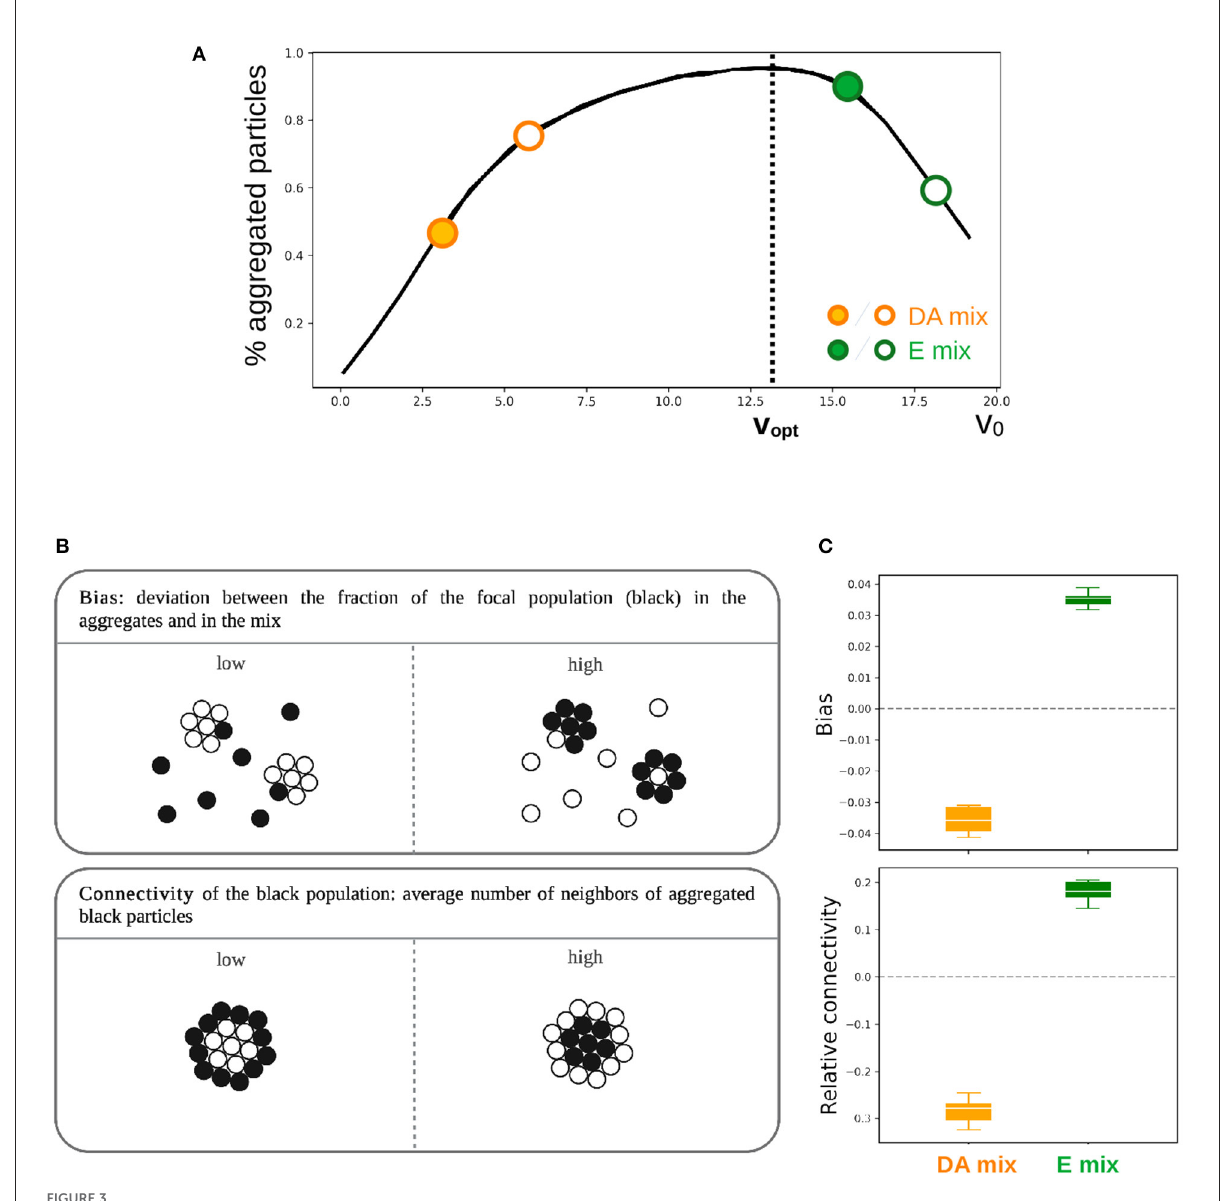
FIGURE3 Effect of heterogeneity in cell motility on the outcome of aggregation in two different types of binary mix. (A) Two populations of particles with different motility (DA mix: v 1 =3 and v 2 =6, E mix: v 1 =13 and v 2 =16) where mixed in equal proportion ( N The focal population is indicated by a full circle. (B) Order parameters allowing to capture the effect of heterogeneity in particles motility on the outcome of aggregation. (C) Aggregation bias and mean connectivity of the focal population within the aggregates estimated at the end of 6 independent simulations as described in (B)